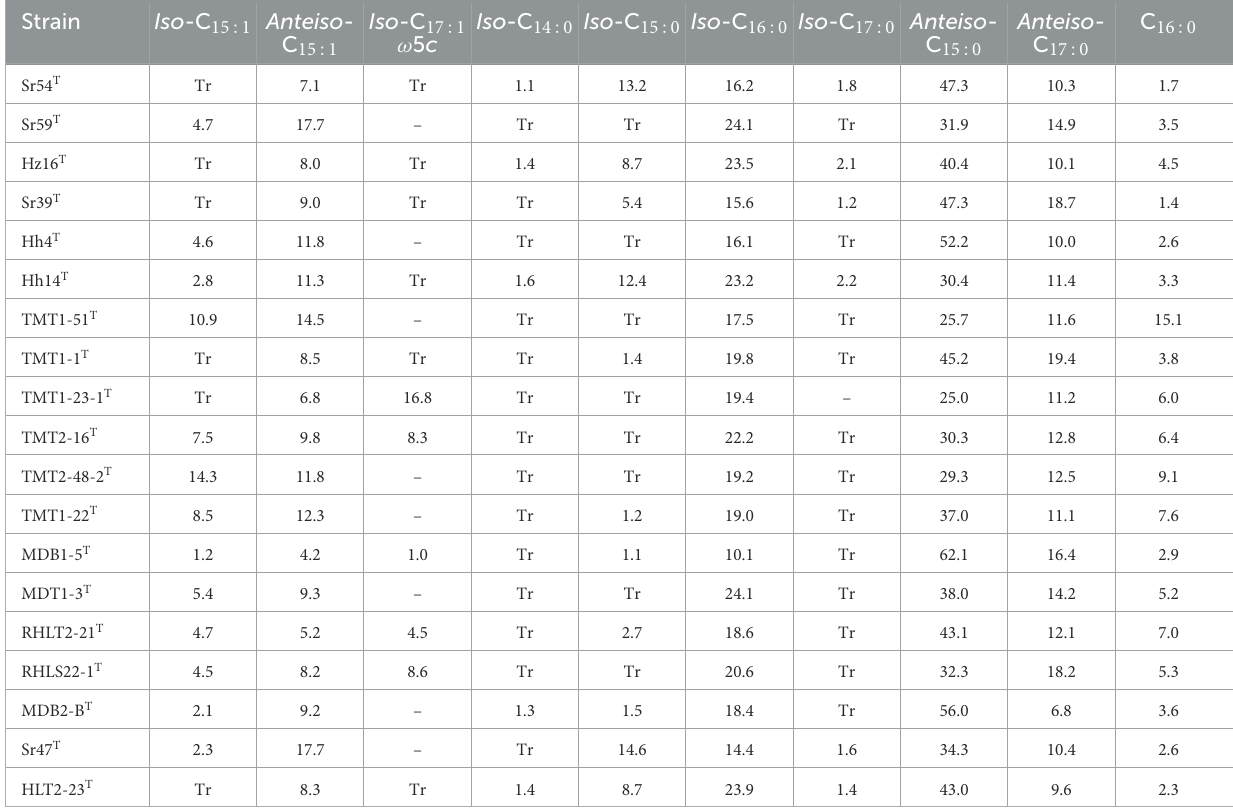
TABLE 2 Cellular fatty acid composition (%) of the type strains of 19 novel Cryobacterium species.